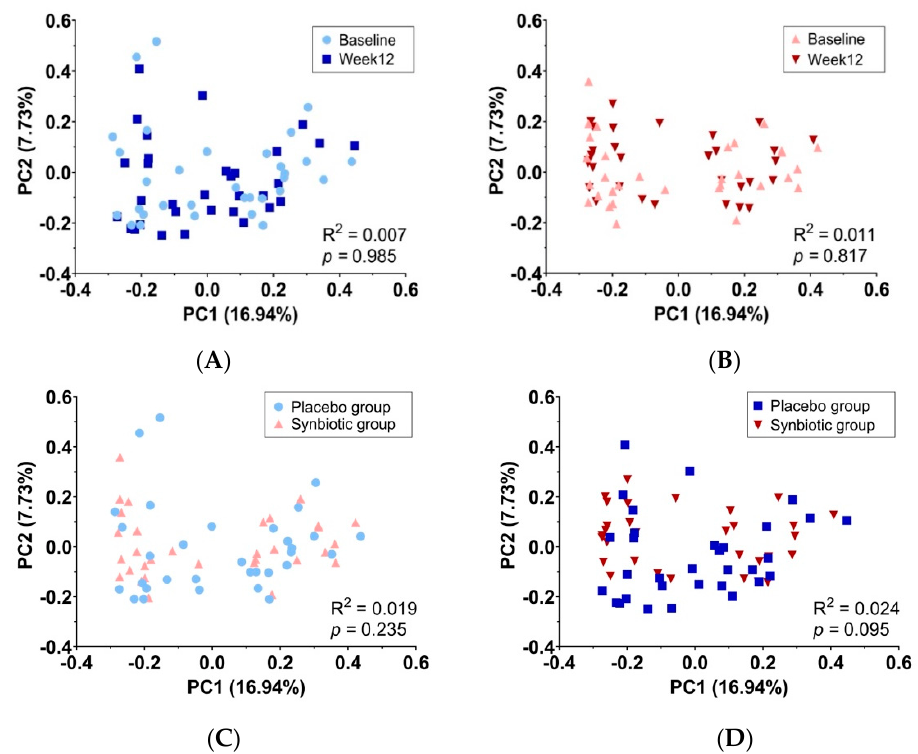
Figure 4. Principal coordinate analysis (PCoA) using Bray–Curtis distances demonstrates the beta diversity of the gut microbiome at the phylum level. Baseline vs. week 12 of ( A ) the placebo group and ( B ) the synbiotic group. The placebo group vs. the synbiotic group at ( C ) baseline and ( D ) week 12.